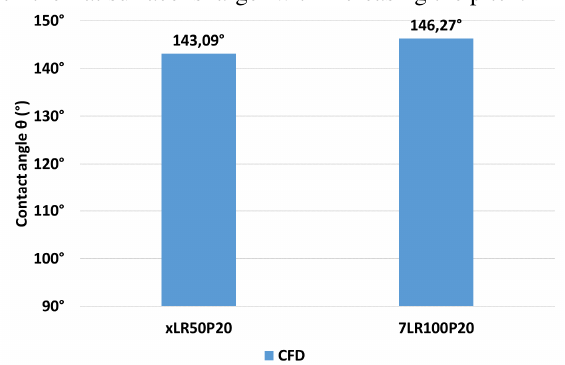
Fig. 10. Influence of the pitch between grooves on contact angle (constant width P = 20 µ